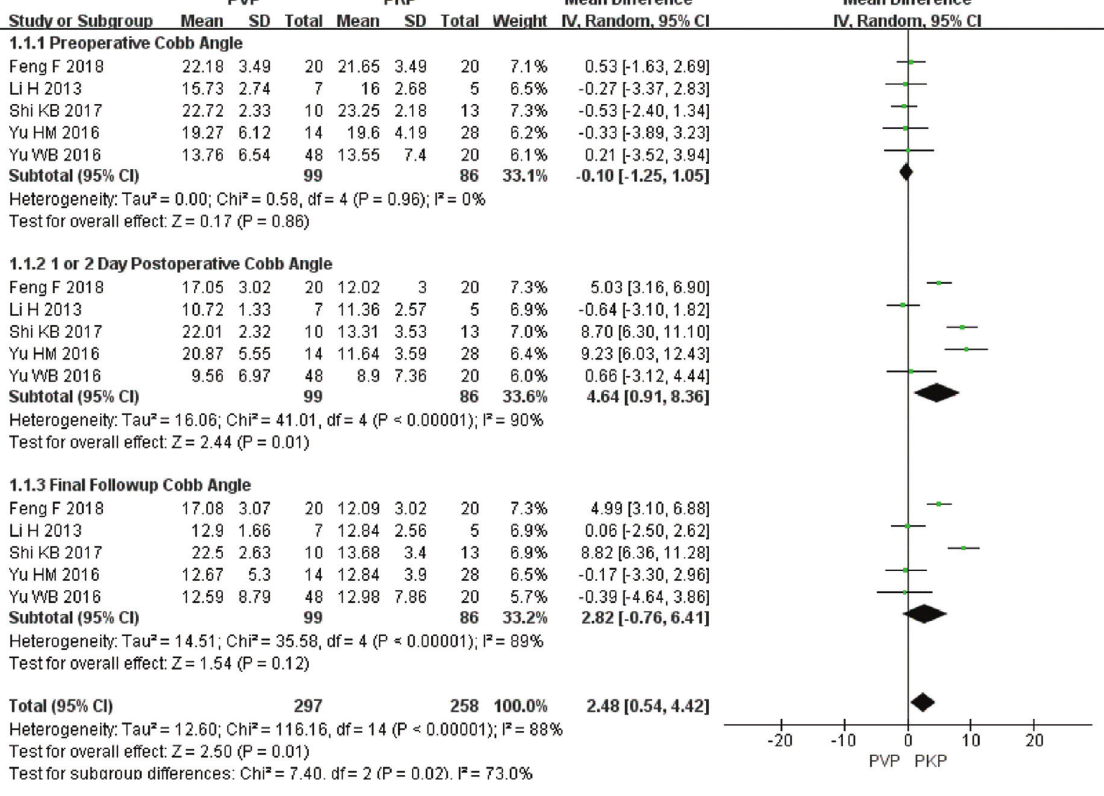
Figure 2. Forest plot to assess Cobb angle between two